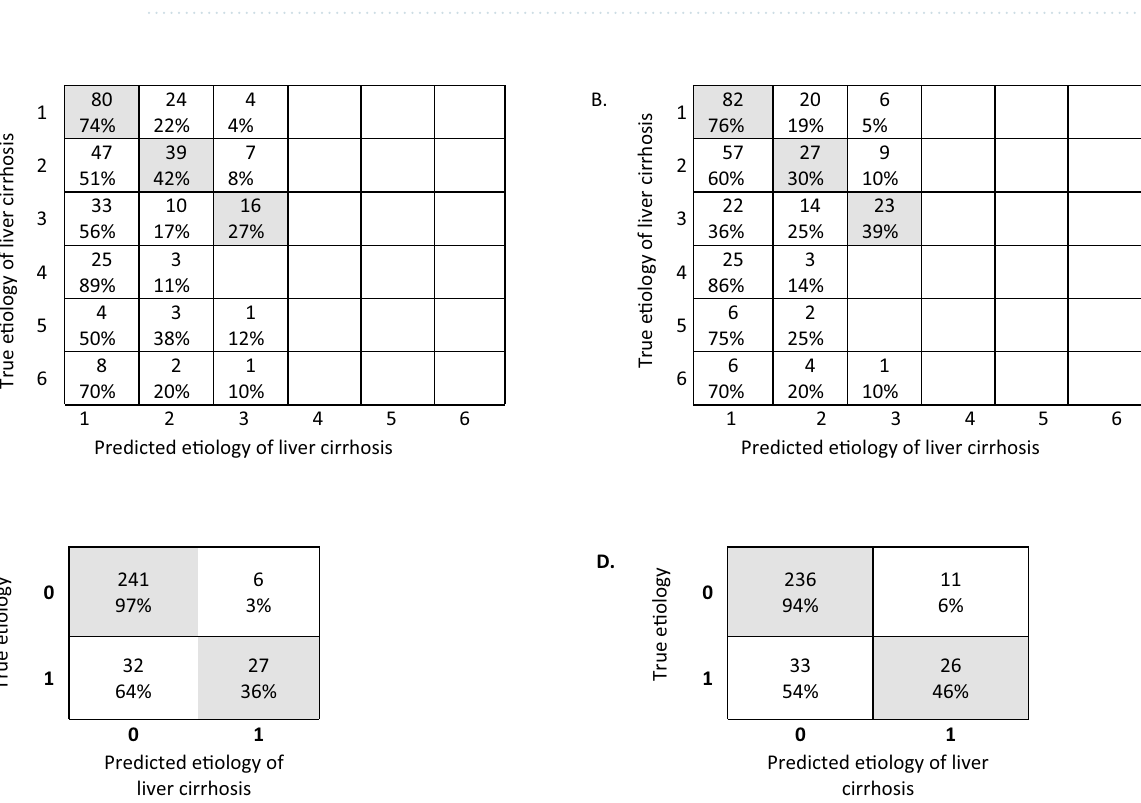
Table 2. Performance metrics of machine learning-based classification of radiomics features in the training subset. MCC Matthews correlation coefficient.